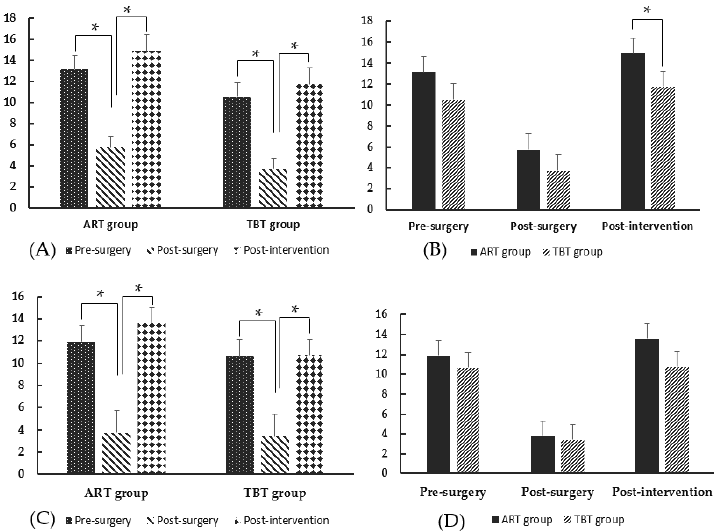
Figure 4. Comparison of muscle strength within and between groups. ( A ) Knee flexion within groups, ( B ) knee flexion between groups, ( C ) knee extension within groups, ( D ) knee extension between groups. * p < 0.05.